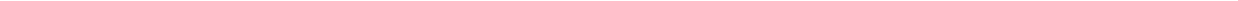
Fig. 3 SKP2 promotes nuclear localization and transcriptional activity of YAP. a , b HEK293A cells were stably transfected with MYC-SKP2, cultured at medium ( a ) or high ( b ) density, and immunostained with a YAP-speci fi c antibody (green). DAPI (blue) was used to stain DNA. Scale bar, 20 μ m. c , d HEK293A cells expressing SKP2 shRNA ( c ) or gRNA ( d ) were immunostained with a YAP-speci fi c antibody (red in c ; green in d ). DAPI (blue) was used to stain DNA. Scale bar, 20 μ m. e HEK293A cells were stably infected with HA-FLAG-YAP and SKP2 shRNA and immunostained with an HA-speci fi c antibody (red). DAPI (blue) was used to stain DNA. Scale bar, 20 μ m. f YAP knockout HEK293A cells (generated by CRISPR-Cas9) were transfected with SFB-YAP (WT or 2KR) with or without MYC-SKP2, and immunostained with antibodies against YAP (red) and MYC (green). DAPI (blue) was used to stain DNA. Scale bar, 20 μ m. g – i qPCR of ANKRD1 , CYR61 , and CTGF in HEK293A cells expressing MYC-SKP2 ( g ), SKP2 shRNA ( h ) or SKP2 gRNA ( i , upper panel). Lower panel in i : immunoblotting of SKP2 and α -tubulin in three independent SKP2 knockout HEK293A clones generated by CRISPR-Cas9. n = 3 biological replicates. Error bars in g – i are s.e.m. Statistical signi fi cance was determined by a two-tailed, unpaired Student ’ s t -test. * P < 0.05; ** P < 0.01; *** P <